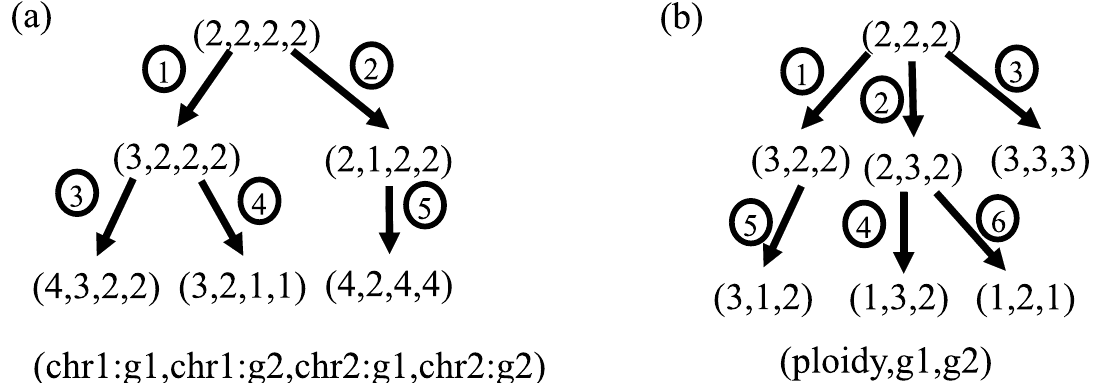
Fig 1. Illustration of ploidyless and ploidy-based trees as might be inferred by the present methods. Circled numbers illustrate the possible mutational event types allowed in each model. (a) Ploidyless tree for two chromosomes with two probes each. Allowed mutation events correspond to (1) gain of a single gene probe, (2) loss of a single gene probe, (3) gain of one copy of (all probes on) a single chromosome, (4) loss of one copy of (all probes on) a single chromosome, and (5) duplication of all measured probes across chromosomes. (b) Ploidy-based tree for a single ploidy probe and two gene probes. Allowed mutation events correspond to (1) increase of ploidy without corresponding gene probe increase, (2) gain of a single gene probe, (3) concurrent gain of ploidy and all gene probes, (4) loss of ploidy without change of gene probe copy number, (5) loss of a single copy of one gene probe, and (6) loss of ploidy concurrent with loss of copy number of all gene